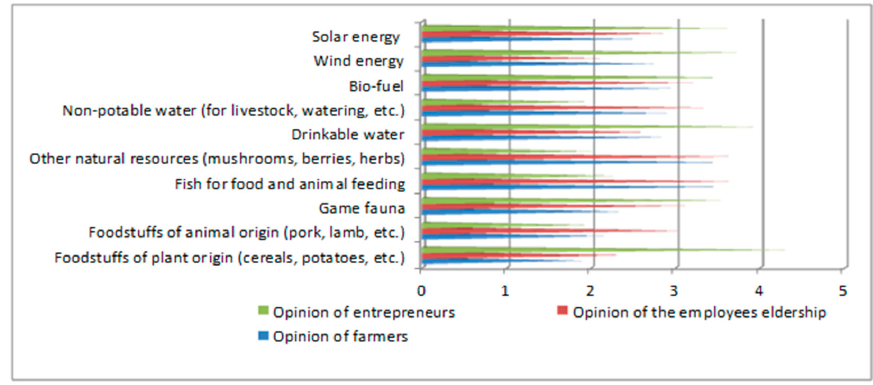
Figure 2. Respondents’ views on the future (2020–2030) potential of supply ES, in score averages.